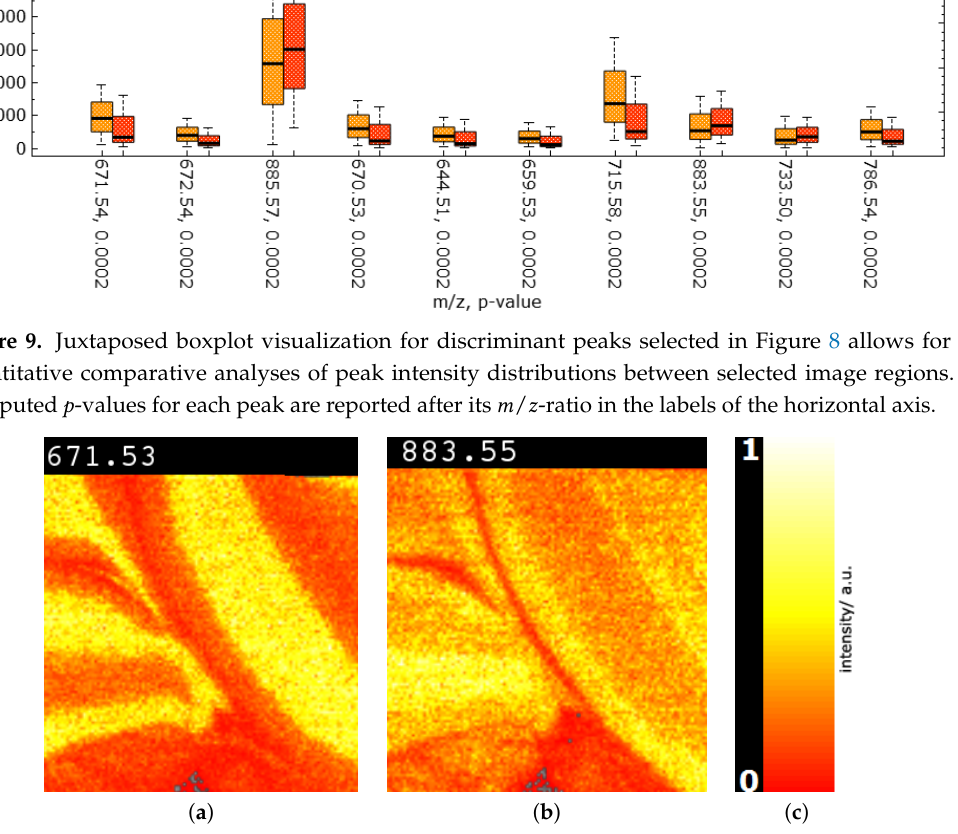
Figure 10. Image-space visualization for peaks with m / z -ratios 671.53 ( a ) and 883.55 ( b ) selected in Figure 9: Multi-hue luminance color map ( c ) exhibits spatial intensity distributions. Methodology applied to mouse cerebellum in negative ion mode data set